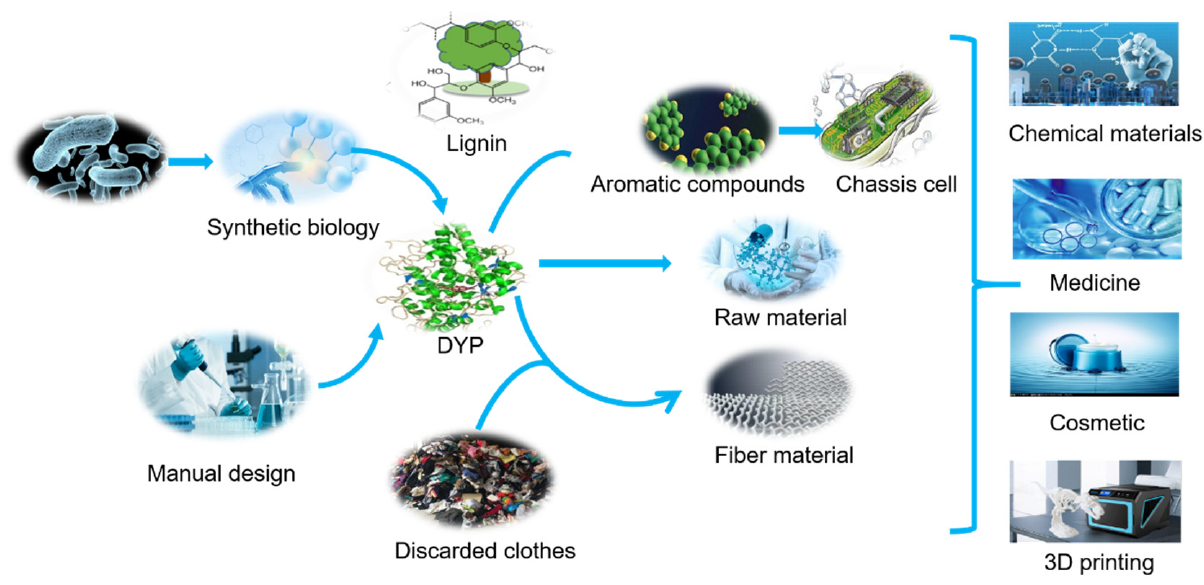
Figure 7. The industrial applications of DyPs.